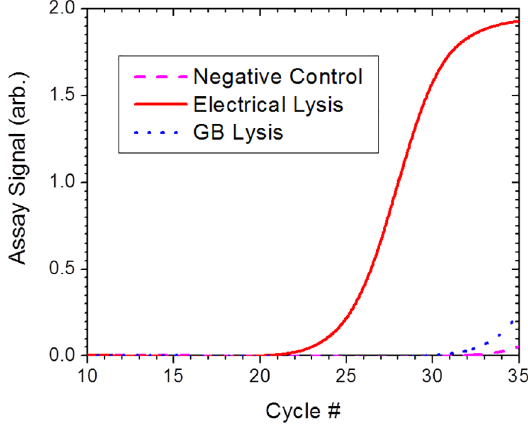
Figure 16. The electrical lysis efficiency of Mycobacterium . The lysis efficiency of Mycobacterium smegmatis cells subjected to electrical lysis which combined electric field with flash heating to 100 u C was verified by determining the amount of released ribosomal RNA from RT- PCR assay performed on the cell lysate. The lysis efficiency of the electrical lysis method is higher than the lysis efficiency of glass bead beating technique by a factor of about 1000 ( , 10 cycles).